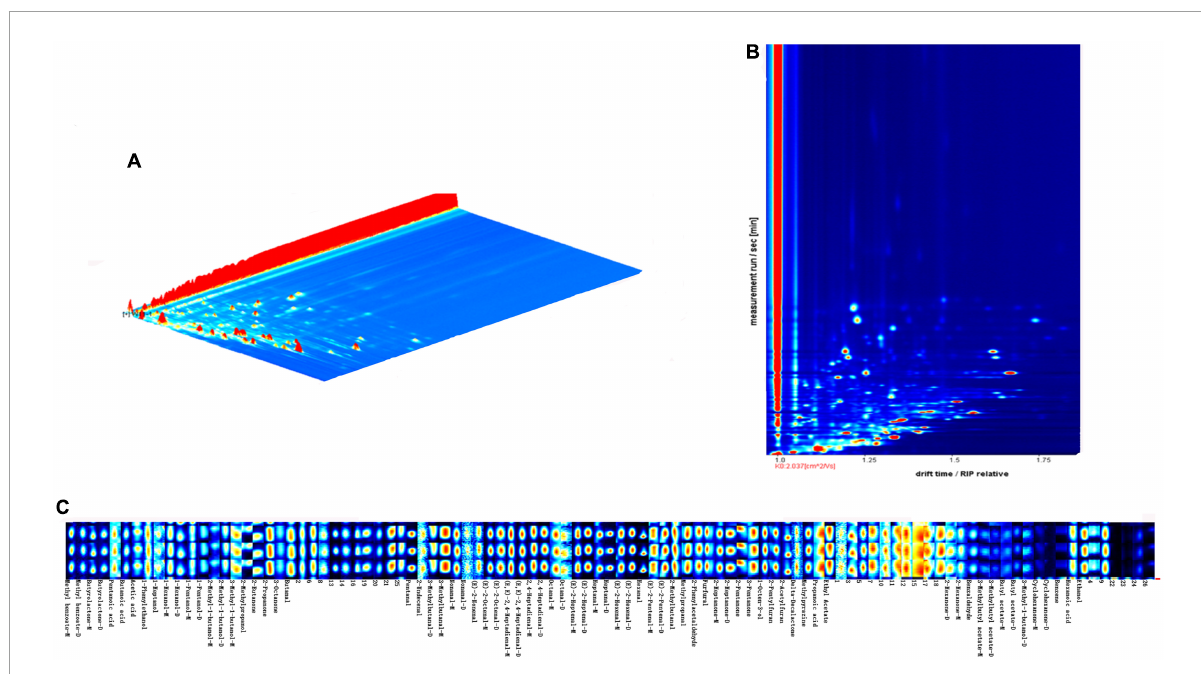
FIGURE5 3D topography (A) , 2D-topographic plots (B) and fingerprinting of VOCs (C) of walnut oil under optimal roasting treatment (120 ◦ C, 20 min).